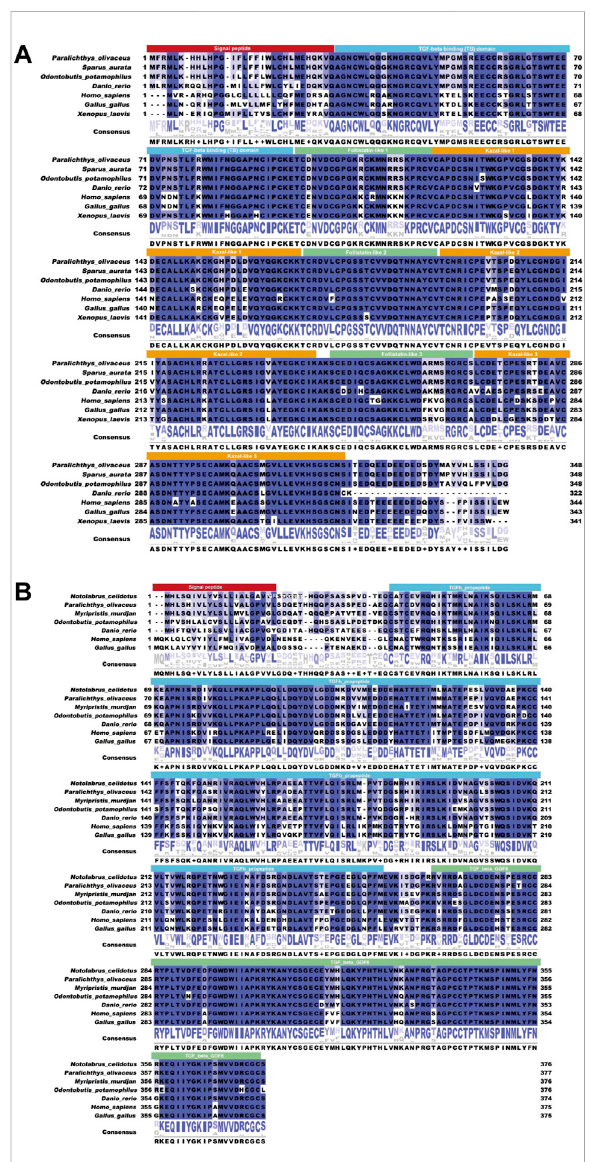
FIGURE 3 The results of the similarity analysis. (A) FST: the solid red box shows the signal peptide; the solid blue box shows the TGF β binding domain; the solid yellow box shows the kazoo-like 2; the solid green box shows the FST-like 3. (B) MSTN: the solid red box shows the signal peptide; the solid blue box shows the TGF β binding domain; and the solid green box shows the TGF β